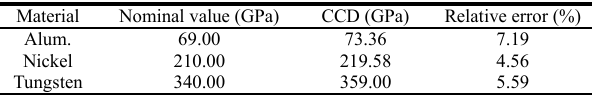
Table 2 Young’s modulus measured by FBG method. Material FBG (GPa) Relative error (%)